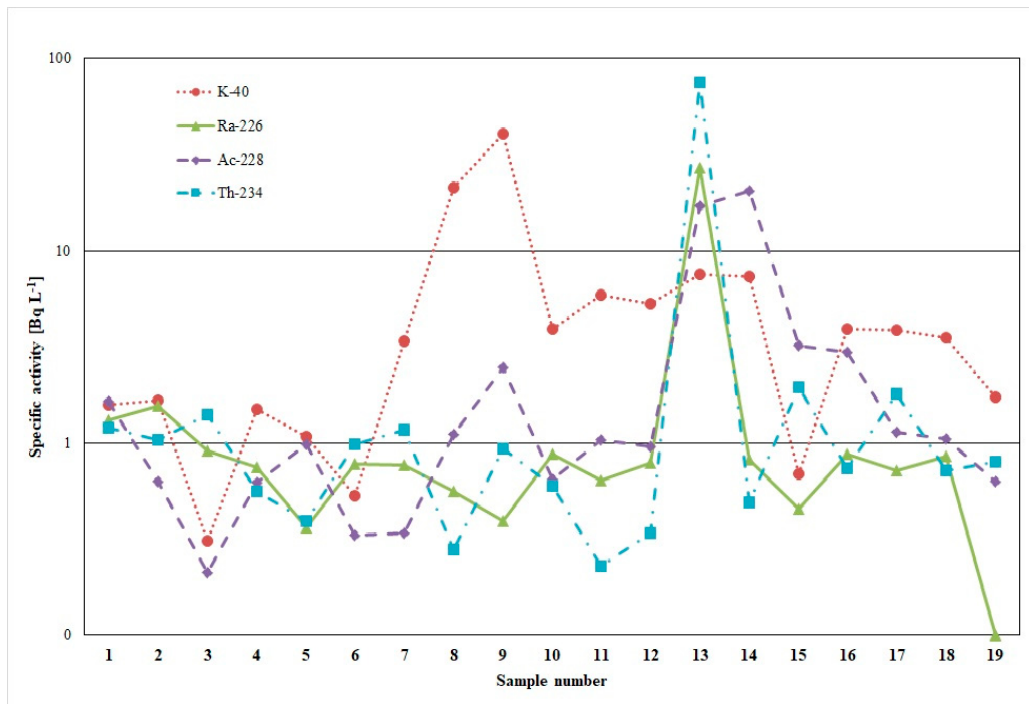
Figure 1. Specific activity of the main isotopes in the tested water samples used in balneology. For comparison, sample number 19 is water from the Białystok water supply system.